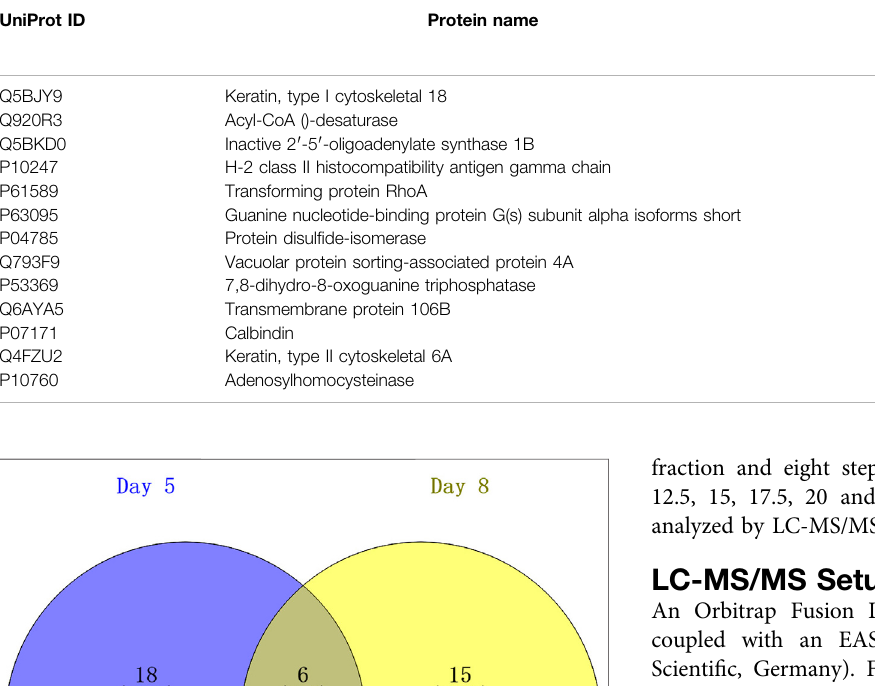
TABLE 1 | ( Continued ) Dynamic urine proteome changes in EAU rats identi fi ed by DIA LC-MS/MS.